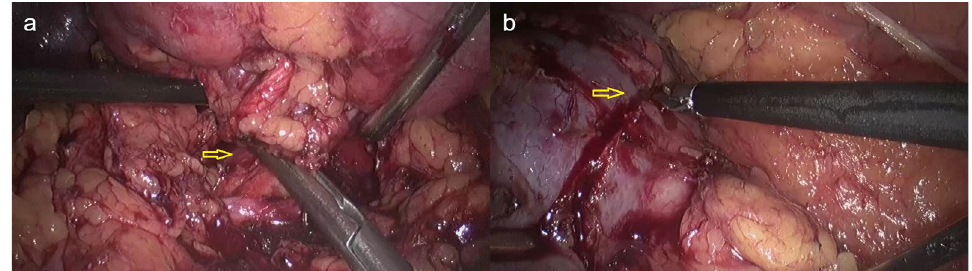
Fig. 3 a Satinsky clamp (marked with yellow arrow) applied en masse to left renal hilum. b Tumor resection begun with scissors (marked with yellow arrow)